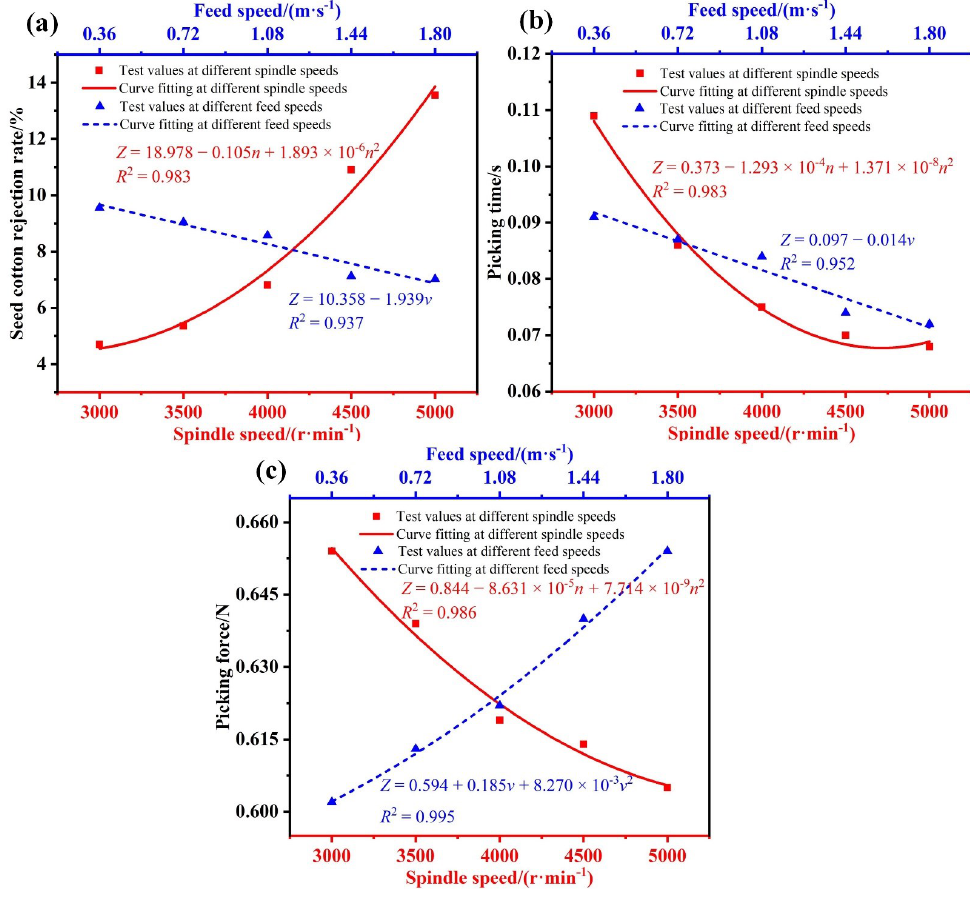
Figure 4. The influence of various experimental factors on the evaluation indices: ( a ) the influence of experimental factors on seed cotton rejection rate, ( b ) the influence of experimental factors on picking time, and ( c ) the influence of experimental factors on picking